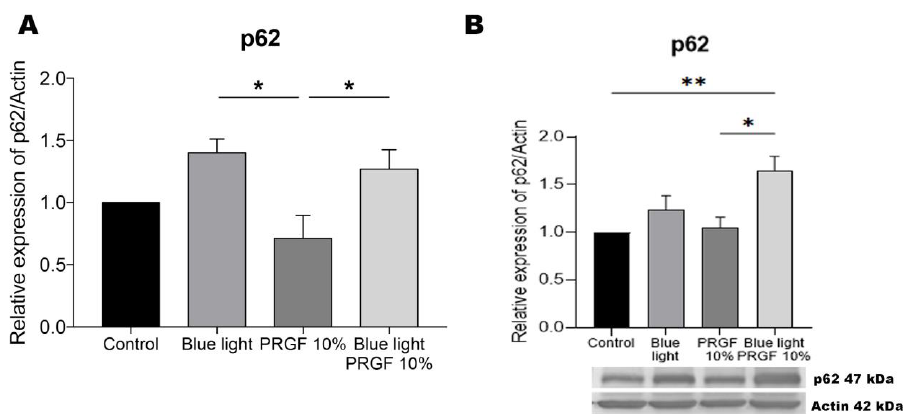
Figure 4. p62/sqstm1 gene expression, and protein expression relative to the expression of actin. ( A ) p62/sqstm1 gene expression measured by qPCR. Results indicate that in response to blue light alone, or in combination with PRGF, its gene expression was significantly increased compared to PRGF alone. One-way ANOVA, Tukey’s multiple comparisons test, * p < 0.05 ( n = 4). ( B ) p62/sqstm1 protein expression measured by Western blotting. Results indicate that PRGF plus blue light led to a significant increase in the expression of this marker compared to the control and PRGF treatments. One-way ANOVA, Tukey’s multiple comparisons test, * p < 0.05, ** p < 0.005 ( n = 4).